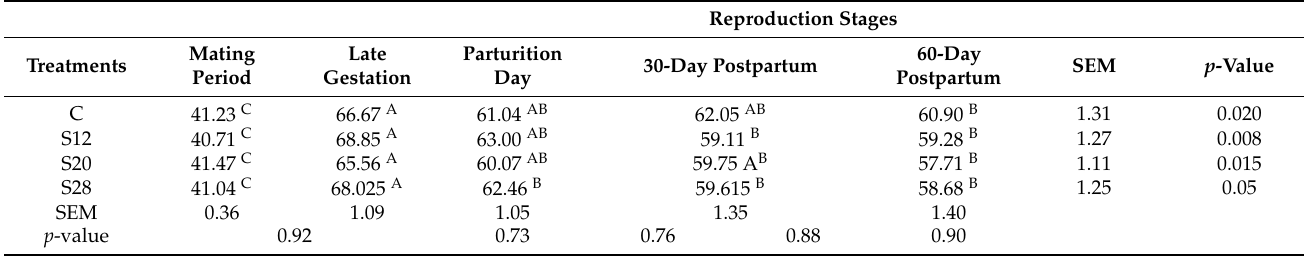
Table 3. The effects of different levels of sunflower hulls in total mixed ration on Awassi ewe’s body weight (kg) during different reproduction stages.